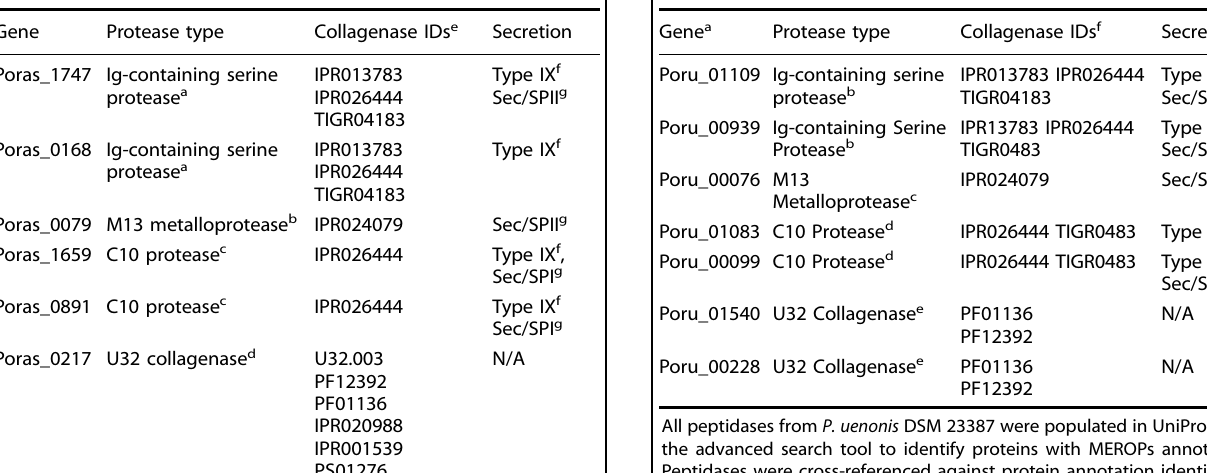
Table 1. Candidate collagenases in P. asaccharolytica . Table 2. Candidate collagenases in P. uenonis